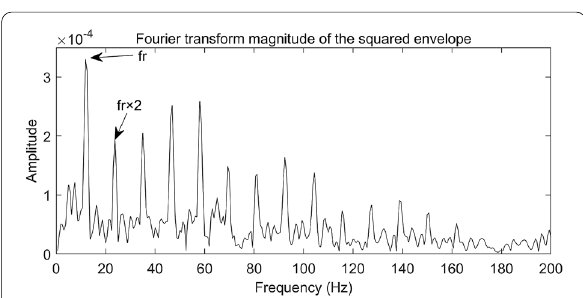
Figure 30 The squared envelope spectrum of the processed signal based on